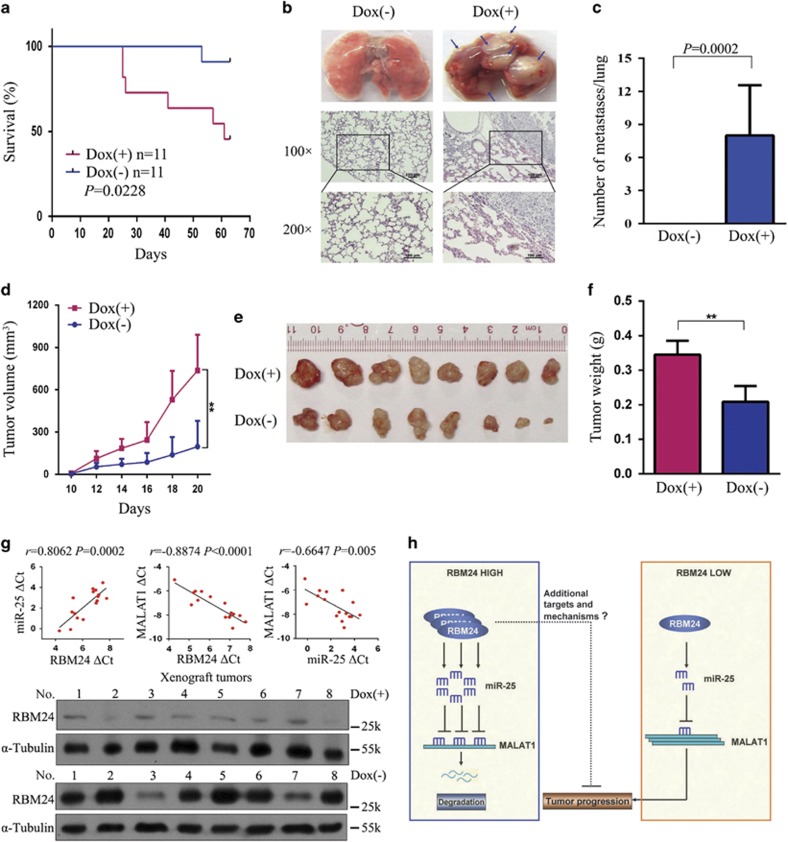
RBM24 suppresses the growth and metastasis of NPC tumors in vivo. (a) Kaplan–Meier survival curves of overall survival duration based on RBM24 expression in the nude mice that were treated with or without doxycycline. (b) Upper: representative images of macroscopic lung metastases; the arrowheads indicate the metastatic nodes. Lower: representative H&E staining of the lung metastatic tumors is shown. (c) Quantification of the average number of metastatic nodes on the surfaces of the lungs (the data are presented as the mean±S.D., Student's t-test). (d) The growth curve indicates that the growth of 5-8 F Tet-Off-inducible RBM24-stable cells was suppressed in vivo after the removal of doxycycline (n=8 per group, the data are presented as the mean±S.D., **P<0.01, Student's t-test). (e) Representative images of xenograft tumors in nude mice after treatment with or without doxycycline. (f) The terminal tumor weight was measured for each group. Representative tumor sizes are shown (the data are presented as the mean±SD, **P<0.01, Student's t-test). (g) Upper: Pearson correlation analysis of the RBM24, miR-25 and MALAT1 RNA levels in the freshly xenografted tumors, as represented by Pearson R scores (n=16, R<0 denotes negative correlation). Lower: the relative levels of RBM24 protein in the freshly xenografted tumors, as determined by immunoblotting. (h) Model of RBM24-induced modulation of the stability and tumorigenesis of MALAT1 by miR-25